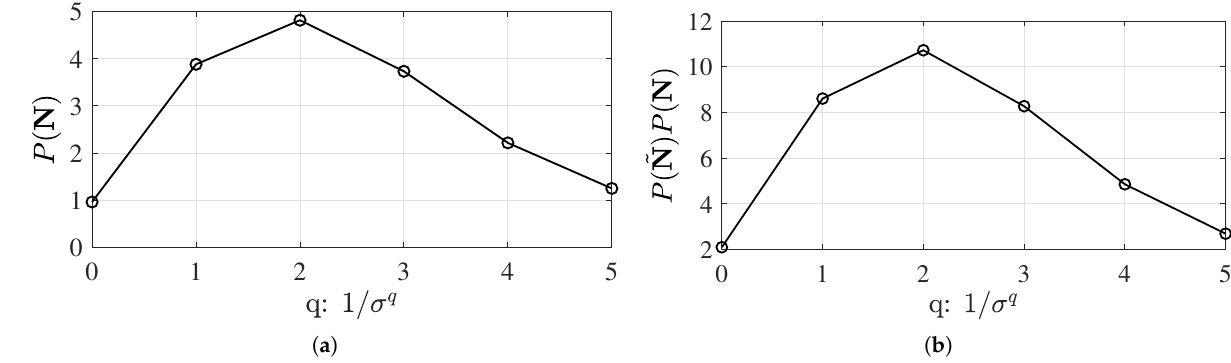
Figure 2. ( a ) The fitting performance P ( N ) evaluated with different 1/ σ q priors and ( b ) the prediction performance P ( ˜ N ) P ( N ) evaluated with different 1/ σ q priors. One data point ˜ N is considered for the